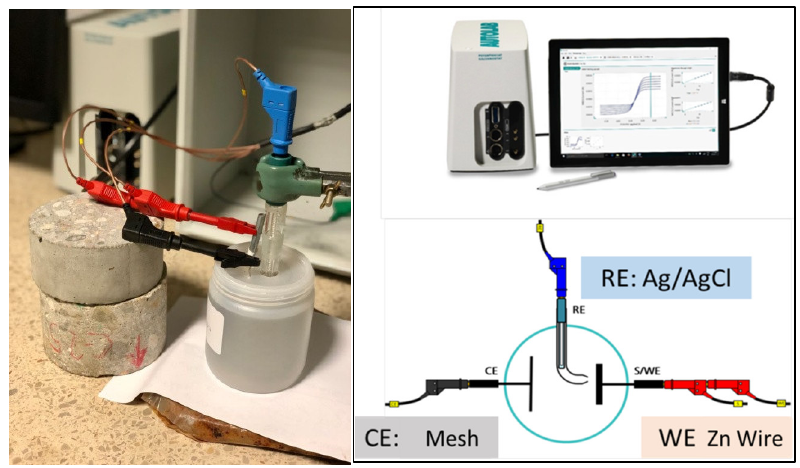
Figure 1. Corrosion cell and Autolab PGSTAT 204 potentiostat/galvanostat assembly together with experimental connections.